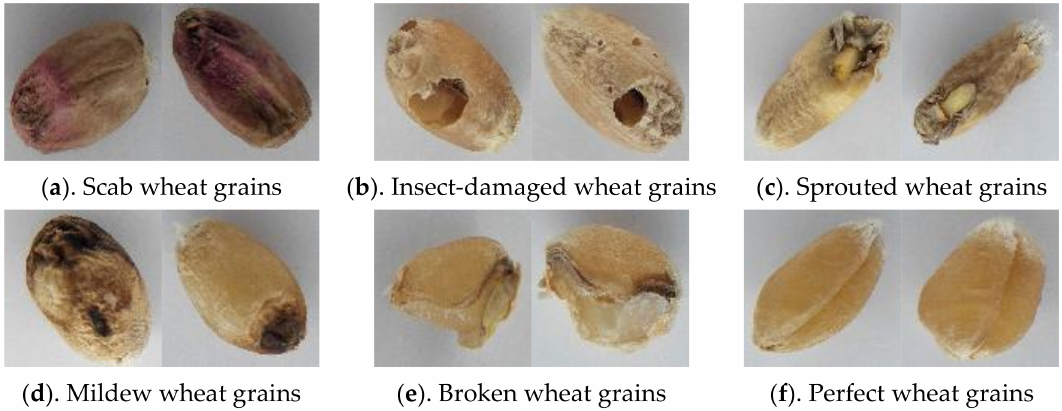
Figure 3. Sample images of imperfect grains and perfect grains of